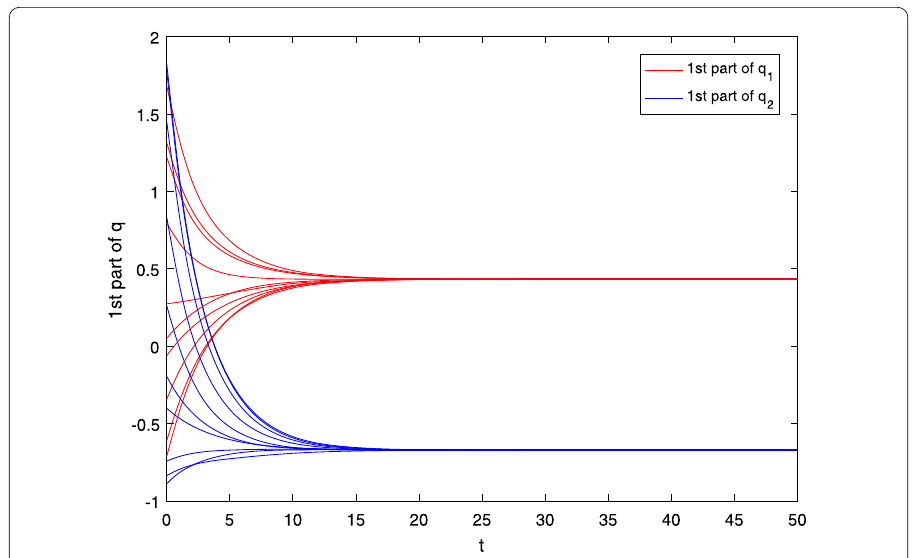
Figure 1 The first part of the state trajectories for system (1) with parameters